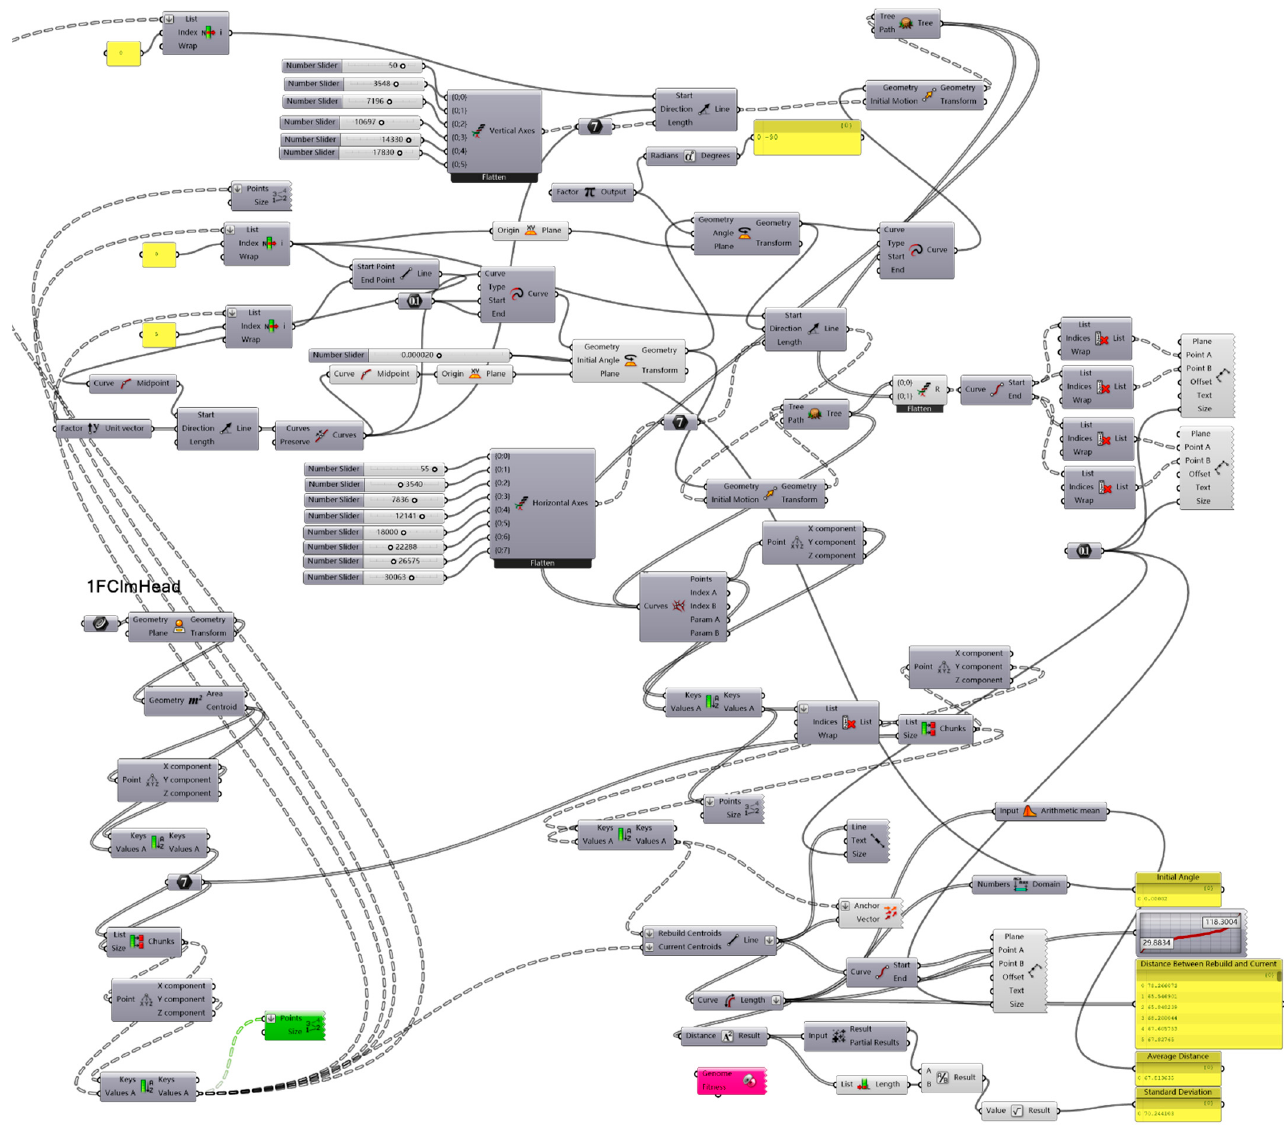
Figure 10. The Grasshopper components of finite element modeling and genetic algorithm.